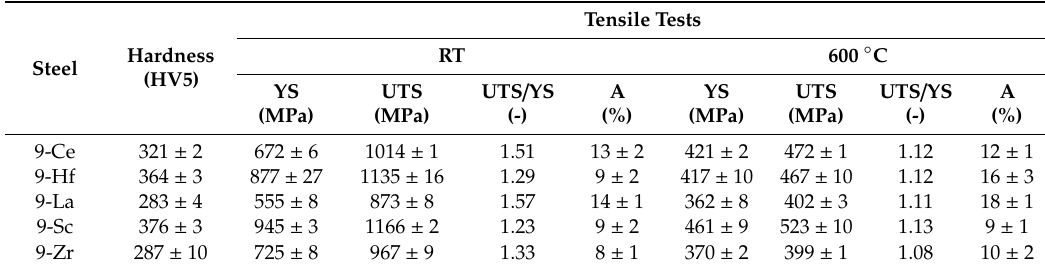
Table 4. Mechanical properties of the prepared